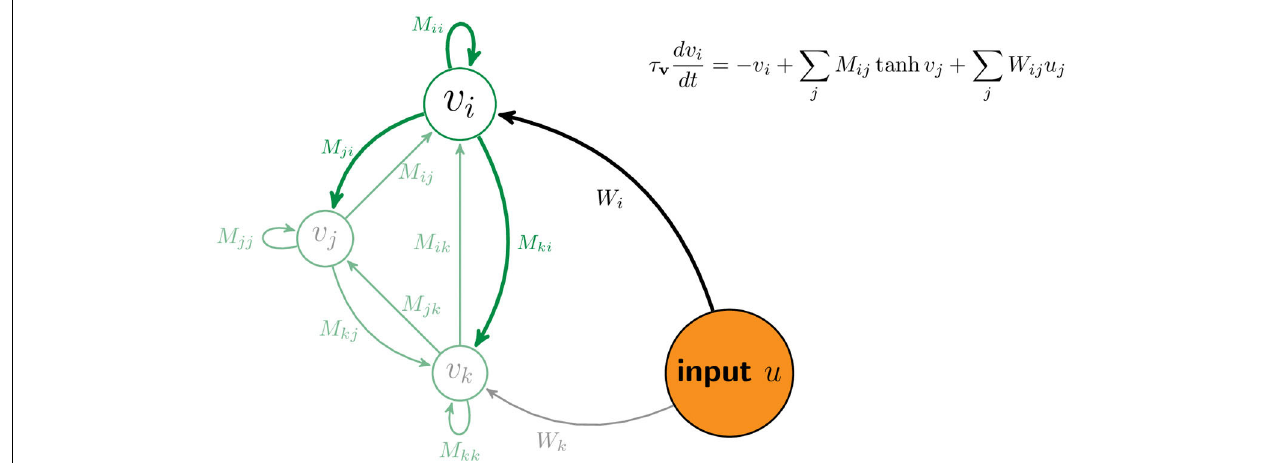
ghosted. The matrix element M ij denotes the connection strength from the j th neuron to the i th neuron. The matrix element W ij denotes the connection strength from j th component of the input, u j , to the i th